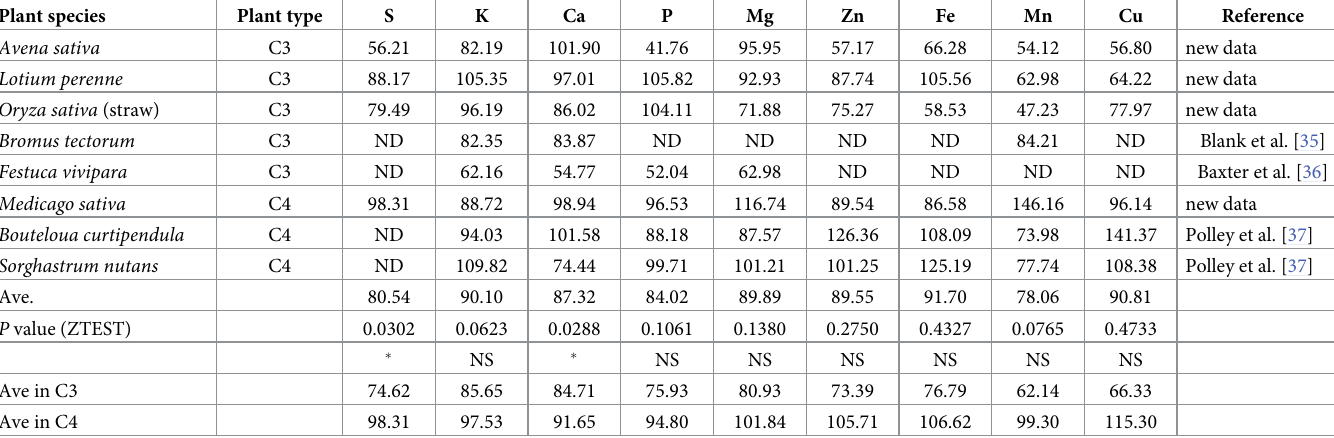
Table 1. Effect of elevated [CO 2 ] on elemental content in feed crops. ND means no data. � Significant at P < 0.05. The values mean the ratio of elemental content under elevated [CO 2 ] to content under ambient condition